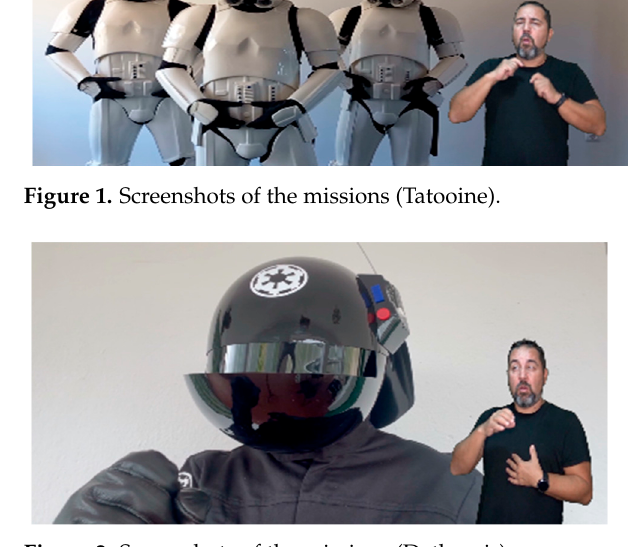
Figure 2. Screenshots of the missions (Dathomir)).